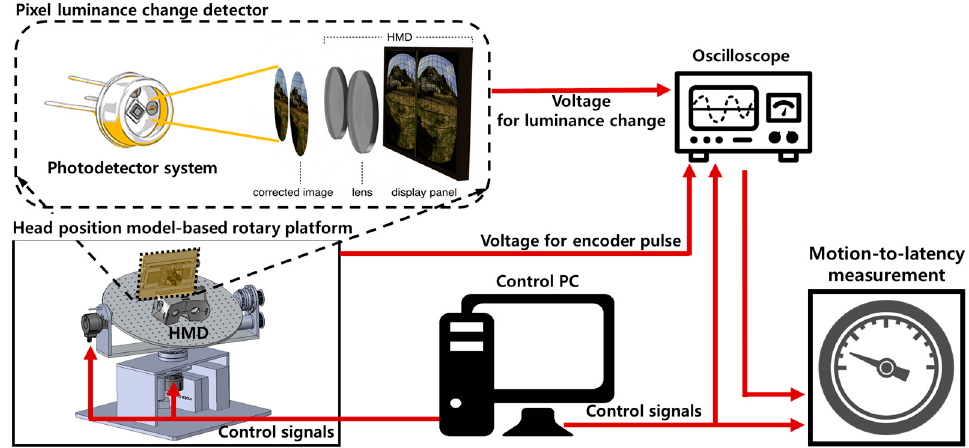
Figure 4. Conceptual architecture of the proposed latency measurement system.